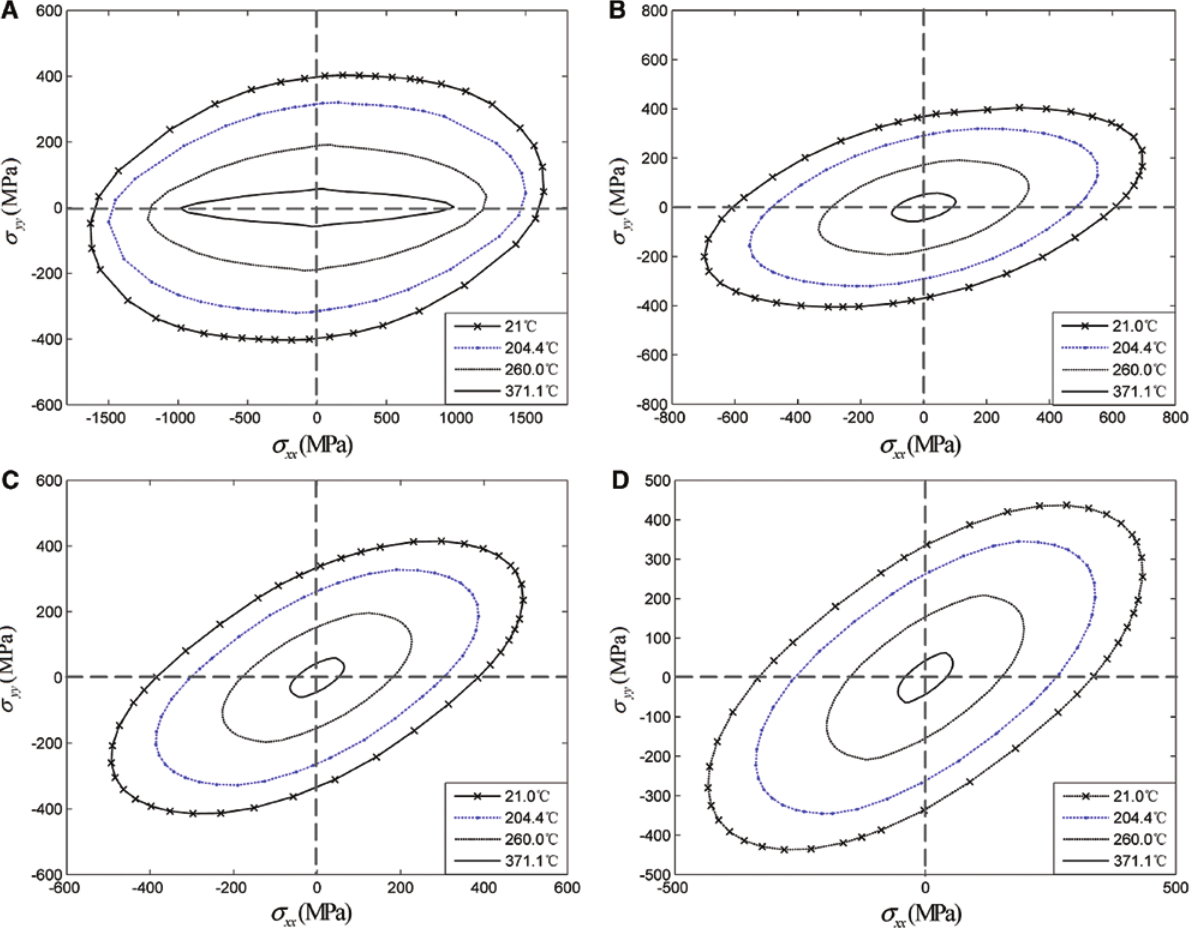
Figure 4 Initial yield surfaces of boron/Al composites at different temperture conditions: (A) 0 ° fiber-reinforced composites, (B) 15 ° fiber- reinforced composites, (C) 30 ° fiber-reinforced composites and (D) 45 ° fiber-reinforced composites.